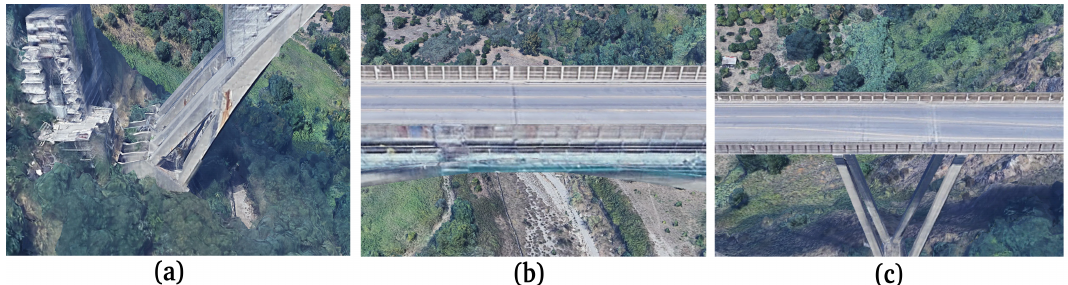
Figure 18. Optical particulars of the “Bisantis” bridge structure: ( a ) Particular 1 of Figure 17, ( b ) particular 5 of Figure 17, ( c ) Particular 6 of Figure 17.